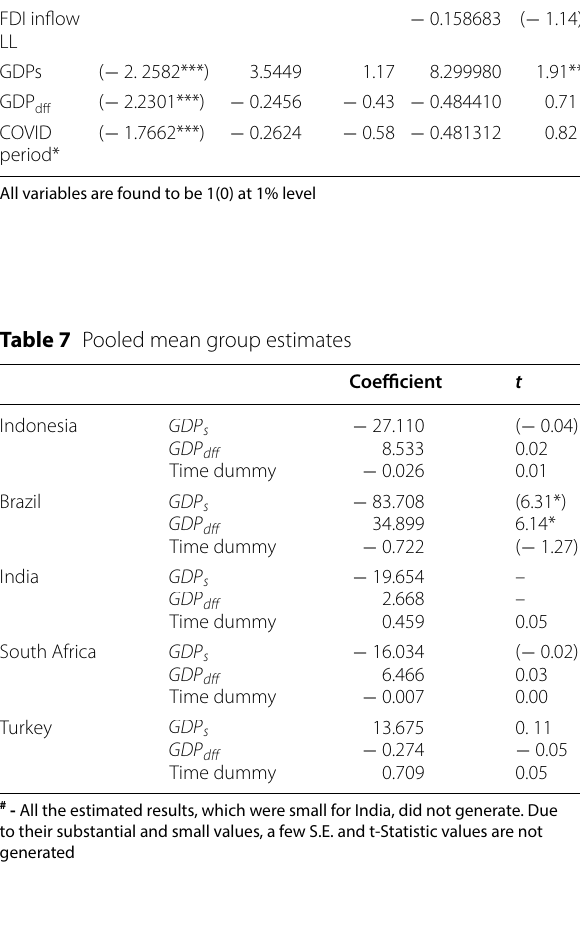
Table 6 Testing for Stationarity of Exploratory Variables Variables Levin‑ Chutest for